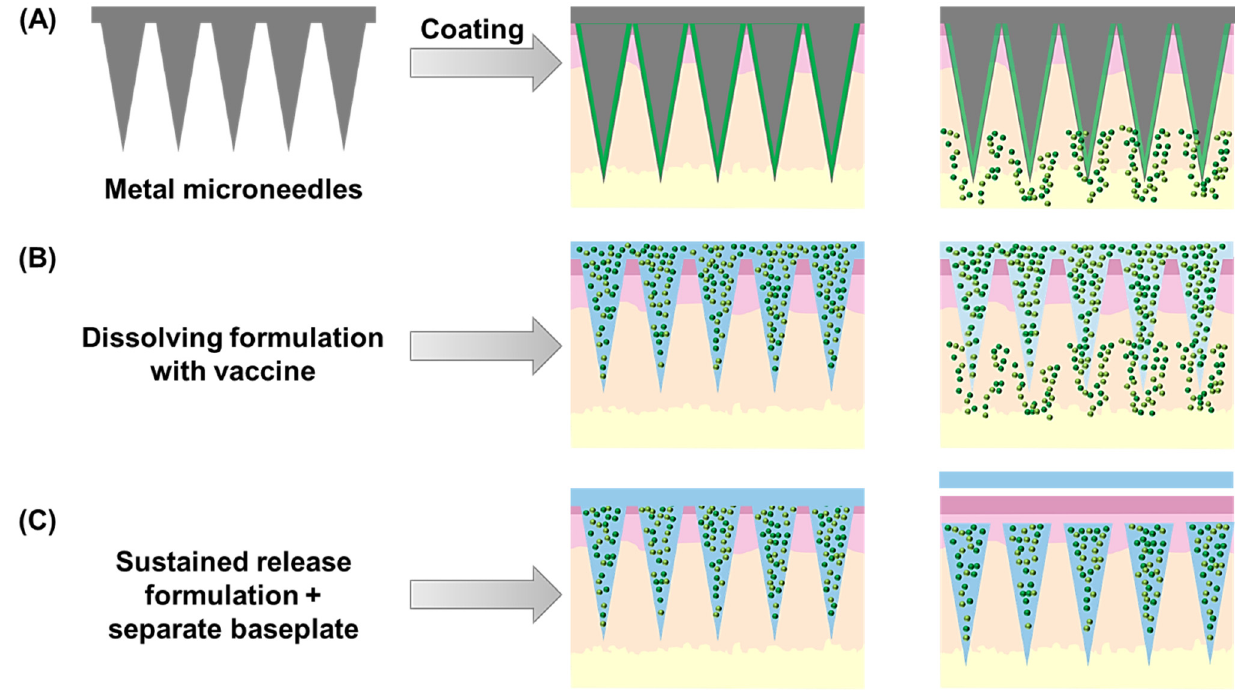
Figure 5. Schematic representation of the three main types of microneedle arrays developed for vaccine delivery. Coated microneedle arrays ( A ) are prepared using a solid array base, usually metallic, which is coated with a dissolving formulation containing the antigen(s) and adjuvant(s). Alternatively, dissolving formulations ( B ) can be used to manufacture the entire array, leading to vaccine delivery upon skin insertion of these self-disposable devices. Finally, sustained-release formulations ( C ) have been used to produce implantable microneedle tips that are left in the skin after insertion, upon removal of a separate baseplate.